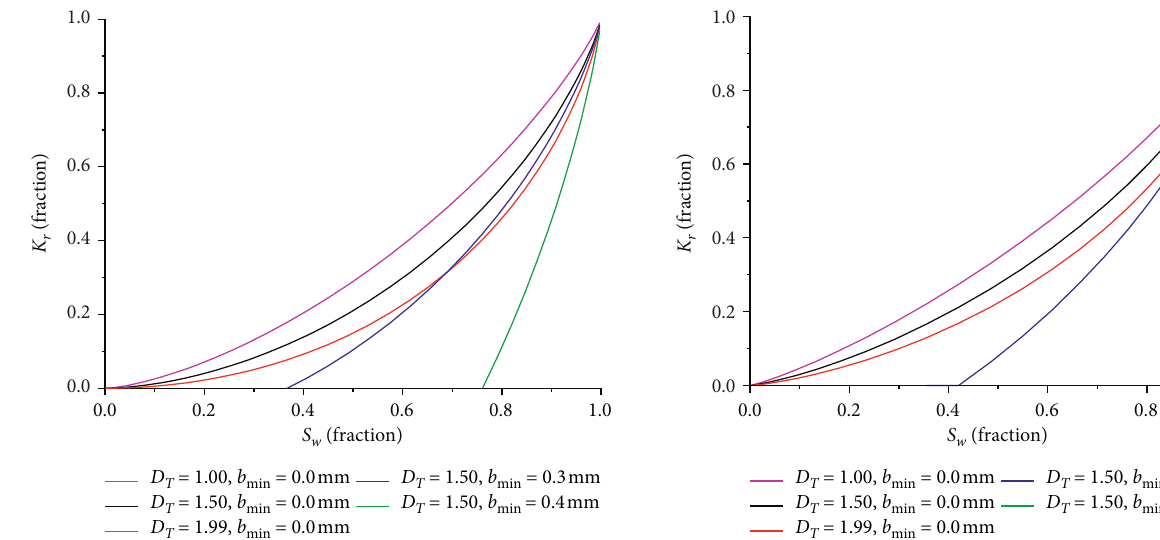
Figure 3: Predicted relationships between relative permeability and saturation with different tortuosity fractal dimensions and minimum apertures. The parameters used in equations (28) and (29) are u � 0.3mm and δ � 0.1 mm.